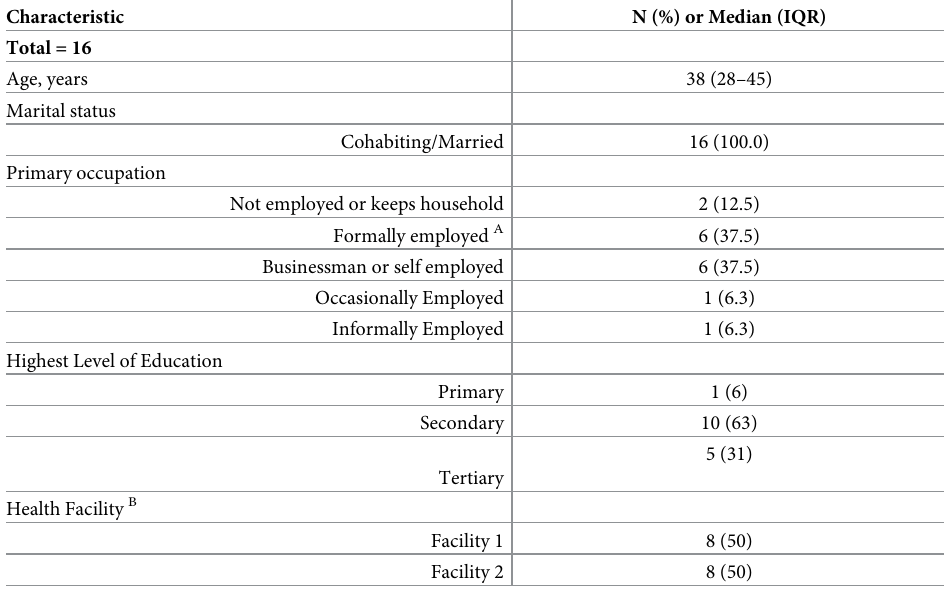
A Employed in an organization, company, institution, or shop. B Health facility and corresponding catchment area where recruitment took